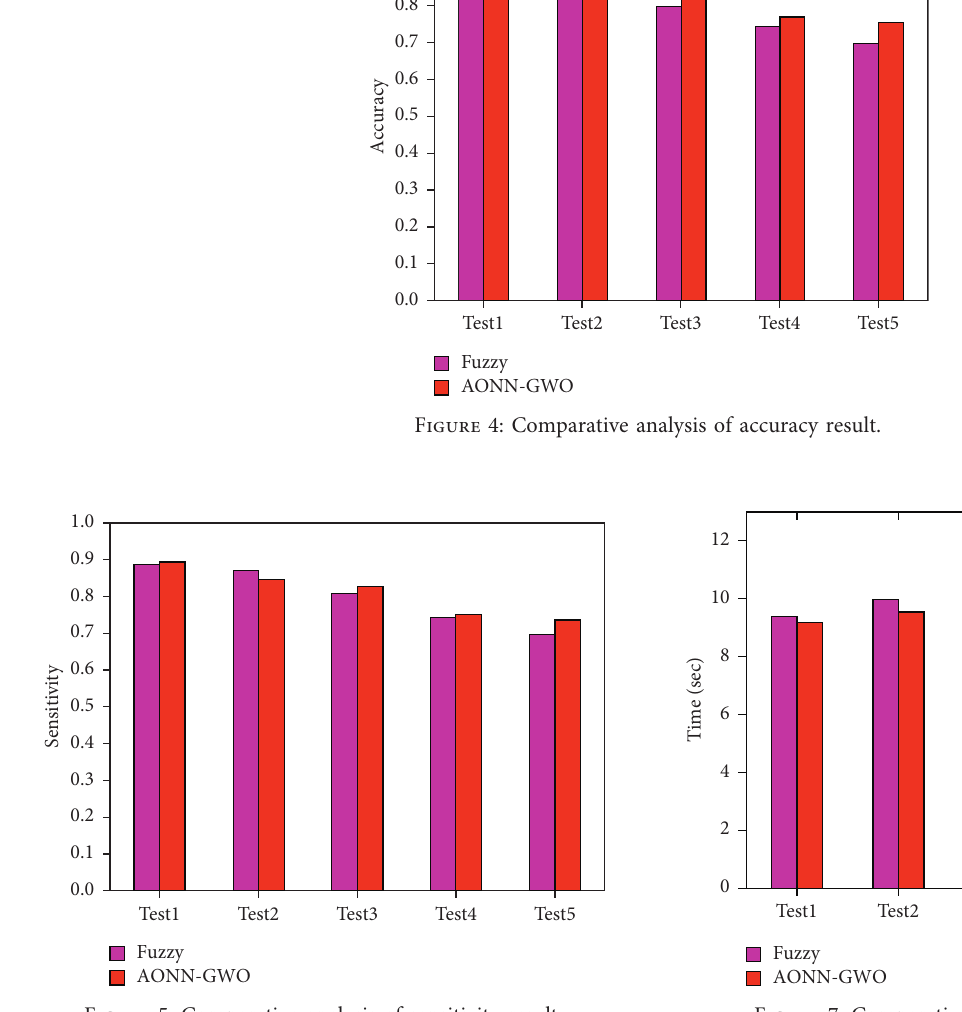
Figure 7: Comparative analysis of time